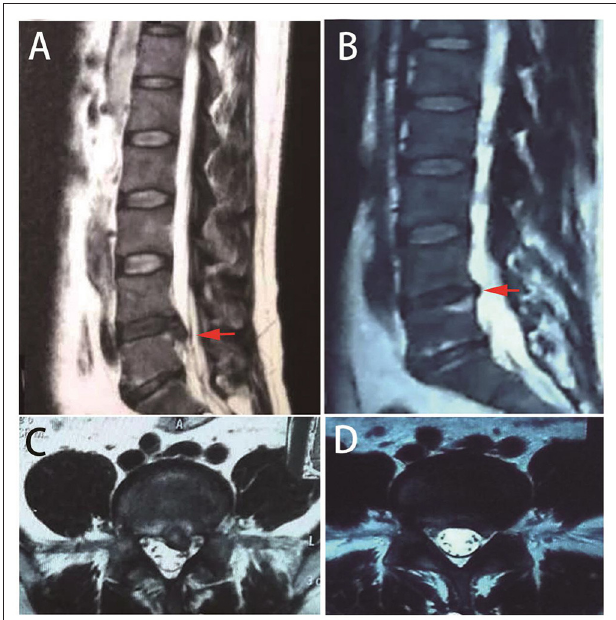
FIGURE 2 | Repeated MRIs of a typical case with spontaneous resolution. A 39-year-old male patient presented with low back pain and sciatica. MRI indicates lumbar disc herniation at L5/S1 [ (A,C) red arrows]. One year later, repeated MRI indicates herniation resolution [ (B,D) red arrows].